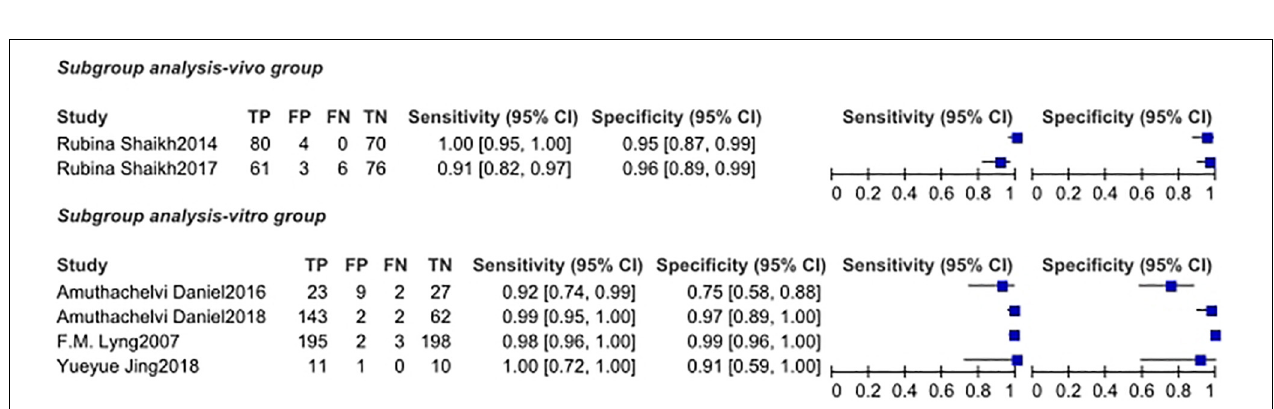
FIGURE 4 | The subgroup analysis of vivo group and vitro